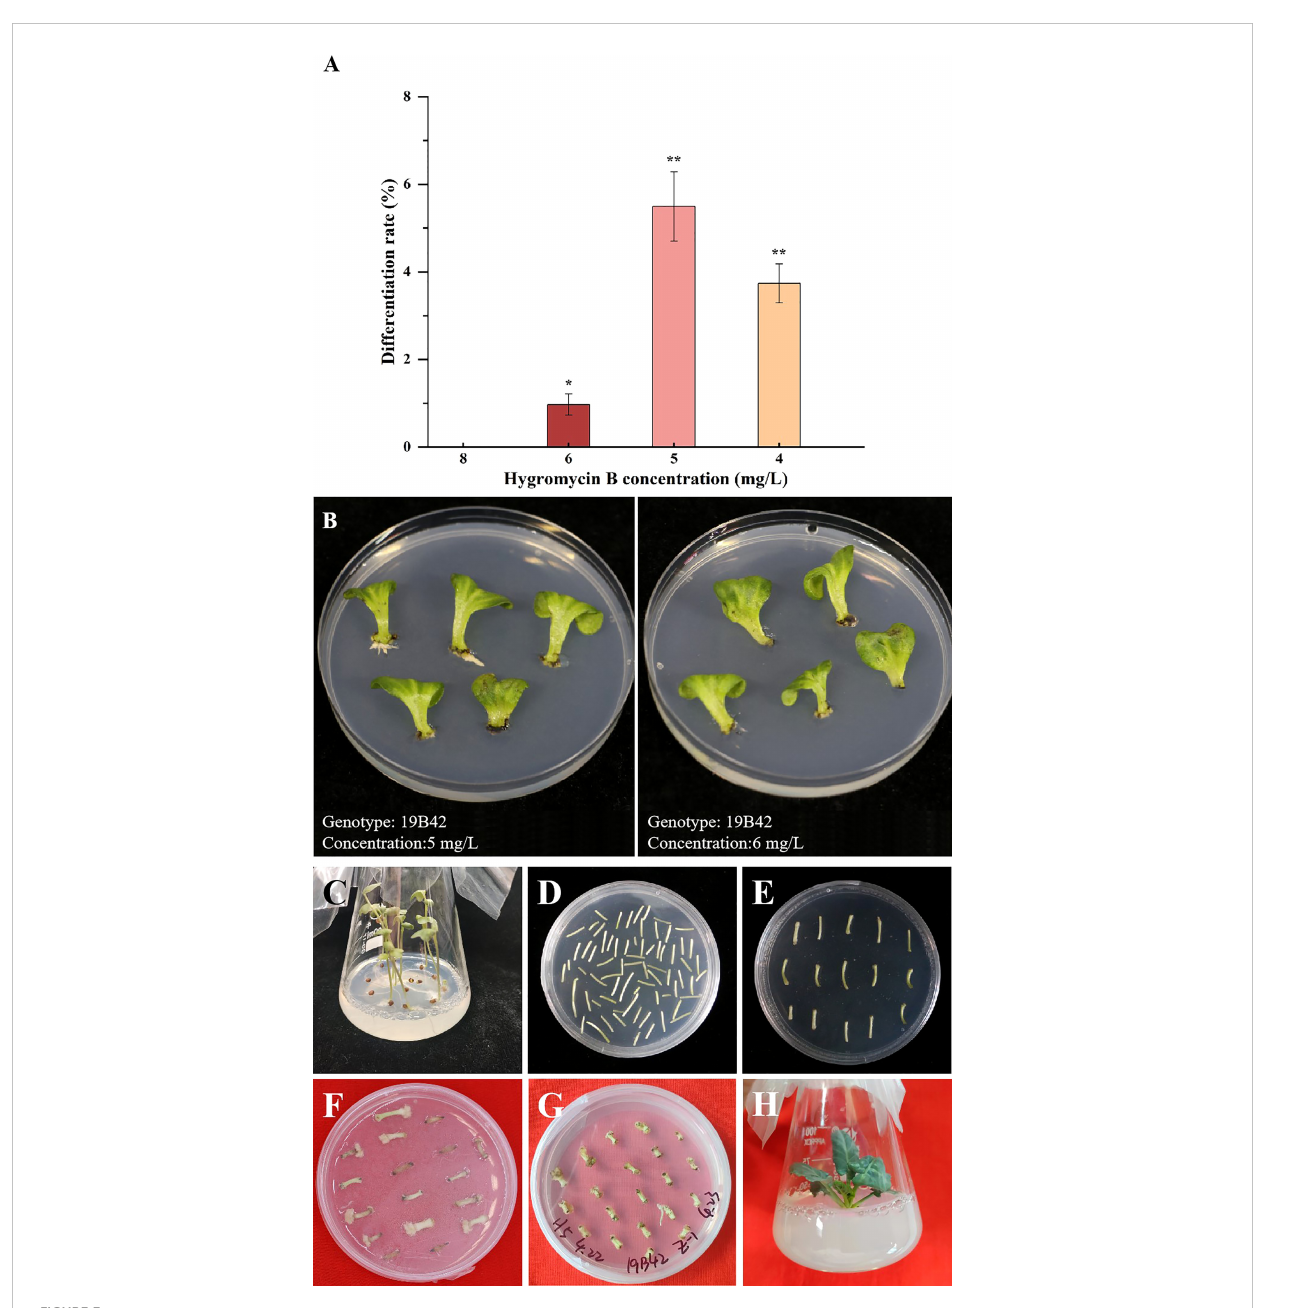
FIGURE 3 The differentiation rate of genotype 19B42 under hygromycin B, and its explants performance. (A) Statistical signi fi cance levels are as follows: ns indicates no signi fi cant difference at a level of 0.05, * indicates a signi fi cant difference at p<0.05; and ** indicates a signi fi cant difference at p<0.01. (B) Performance of cotyledons (19B42) after 45 days of selective culture. (C-H) Performance of hypocotyls(19B42) in transformation